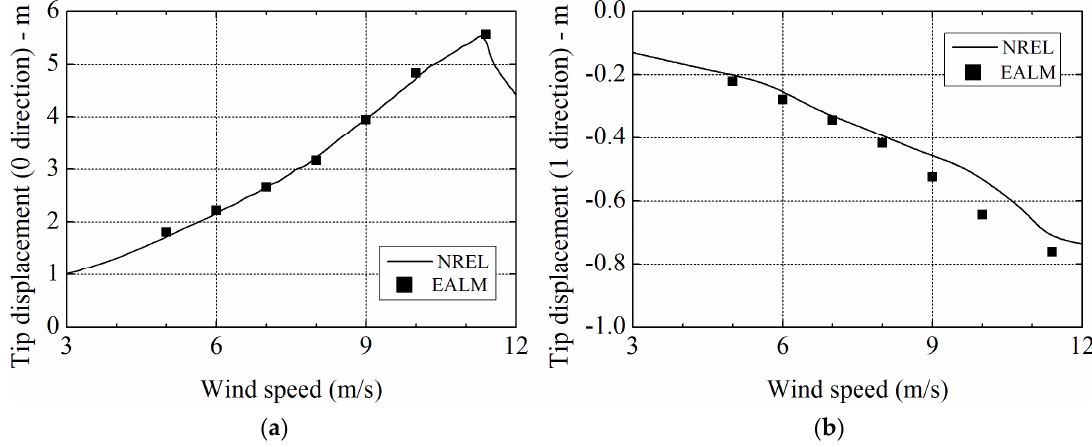
Figure 14. Comparison of the tip displacement results between elastic actuator line model (EALM) and